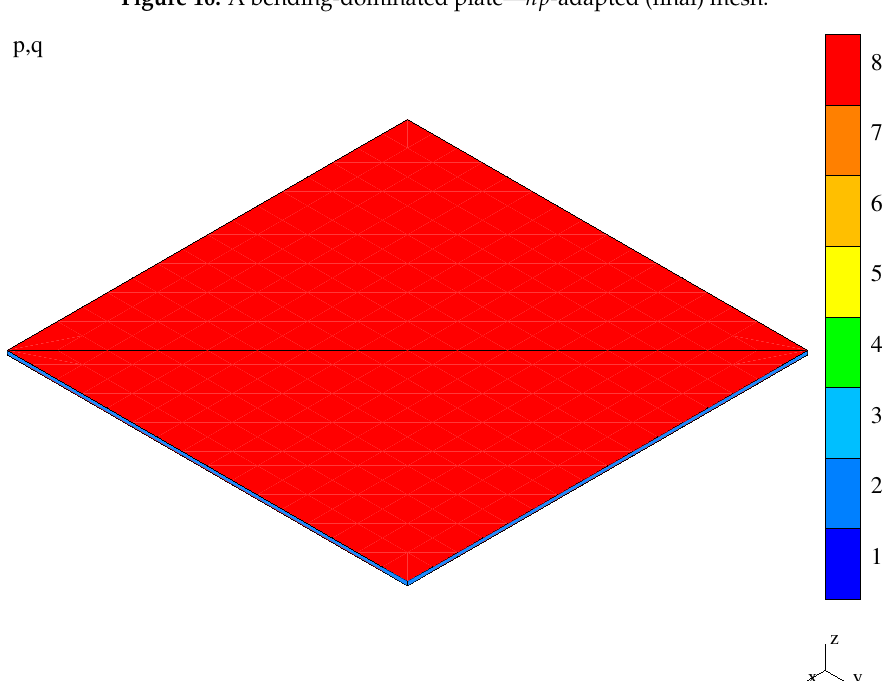
Figure 16. A bending-dominated plate— hp -adapted (final) mesh.